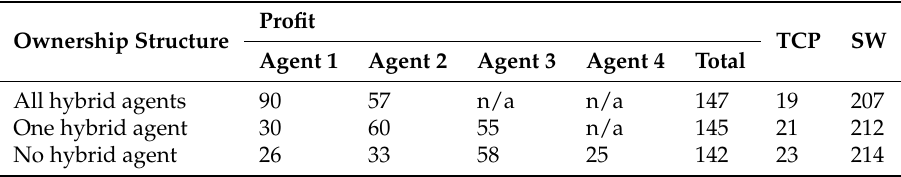
Table 6. Case study: profits and social welfare ($ thousand) for different market ownership cases (Max TPP